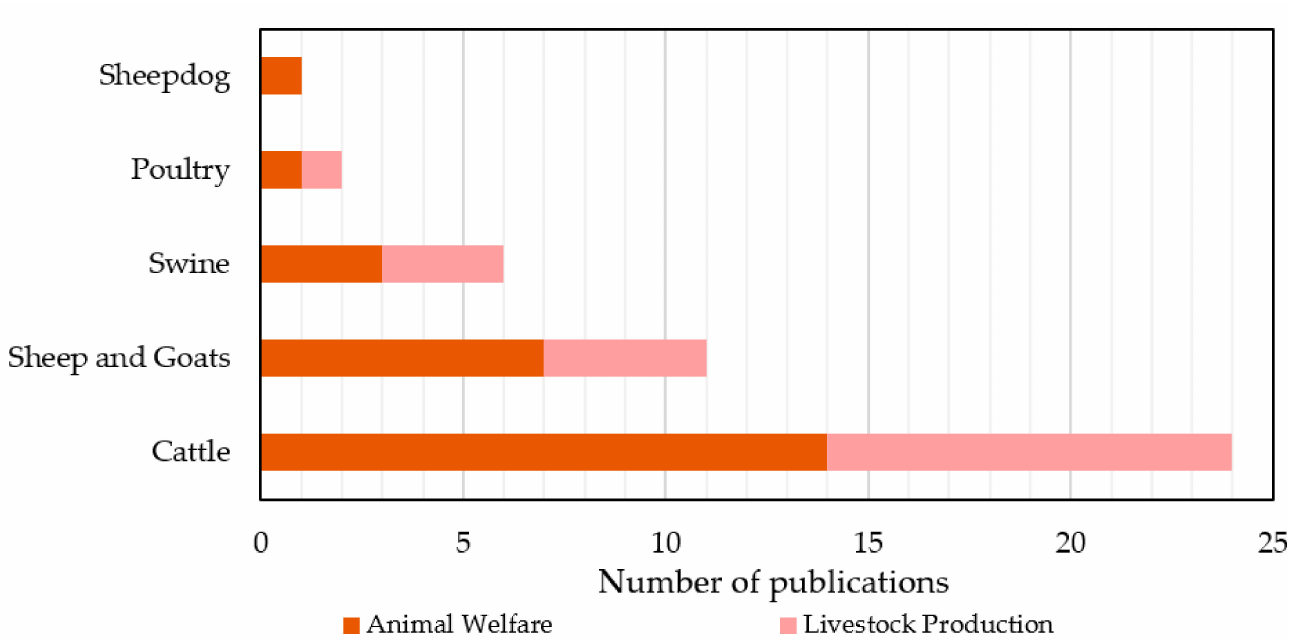
Figure 10. Frequency of animal species in studies concerning livestock management by using machine learning